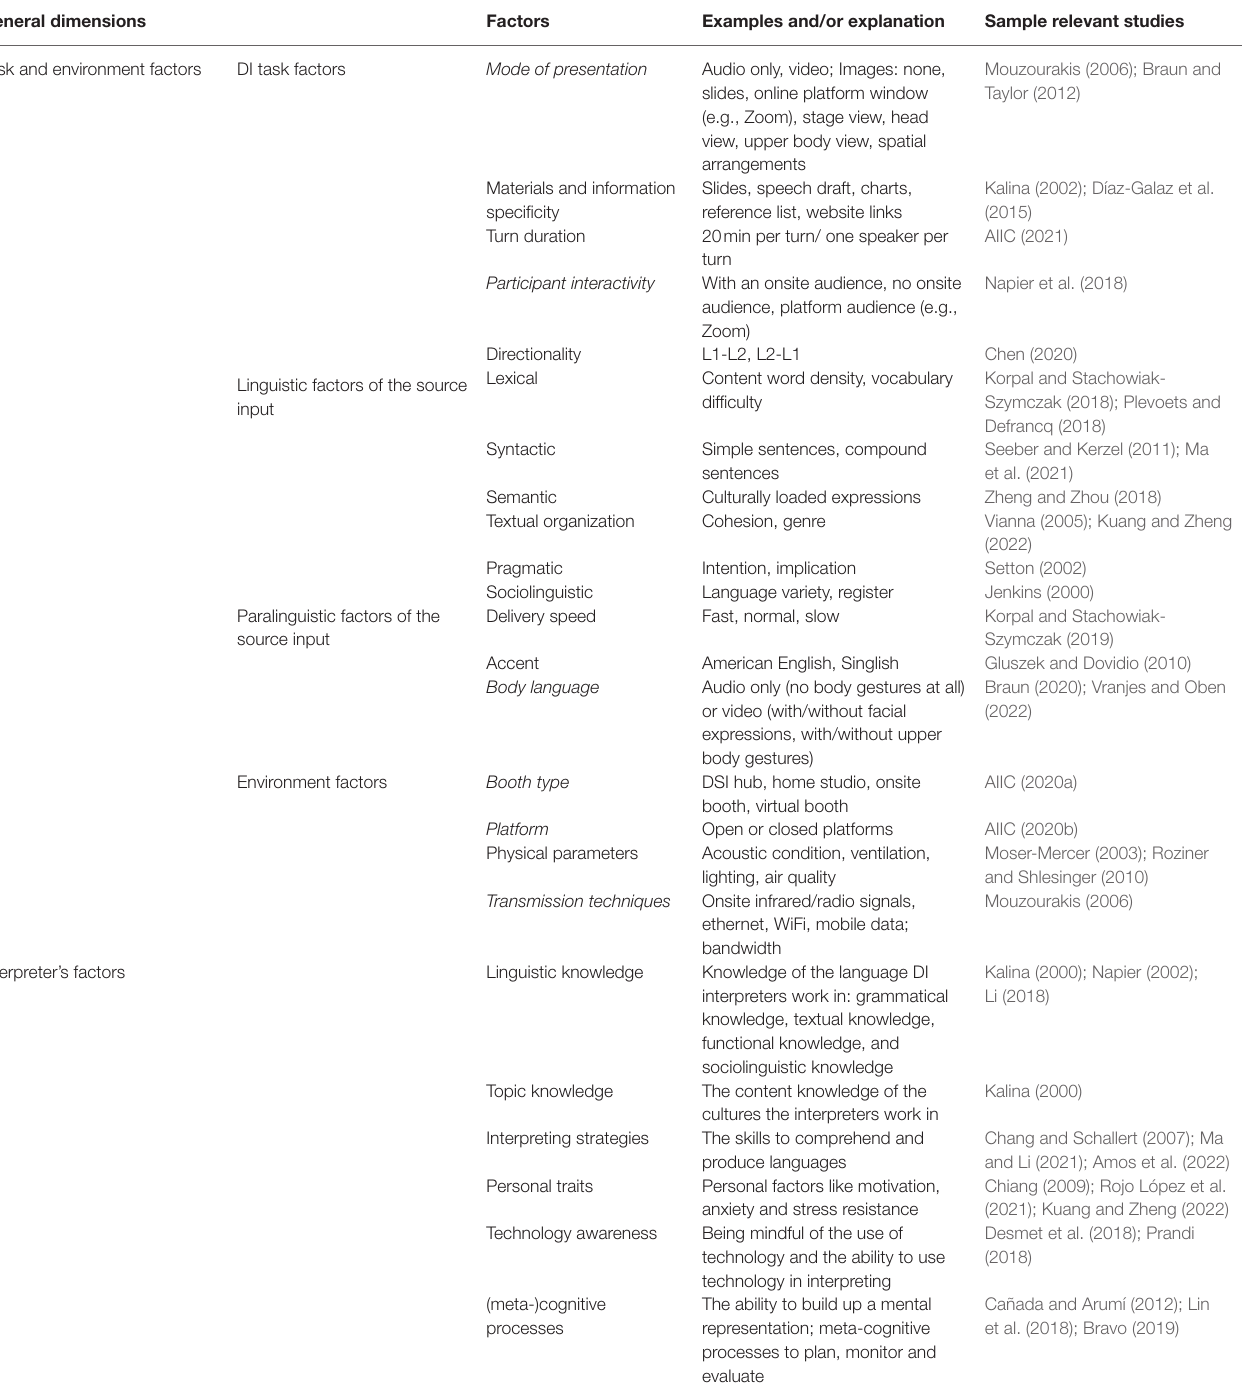
TABLE 1 | An overview of previous studies on the causal factors that change interpreters’ cognitive load during